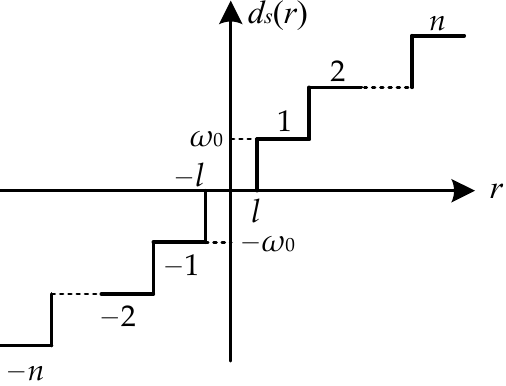
Figure 3. The actuator dead zone in speed regulation.